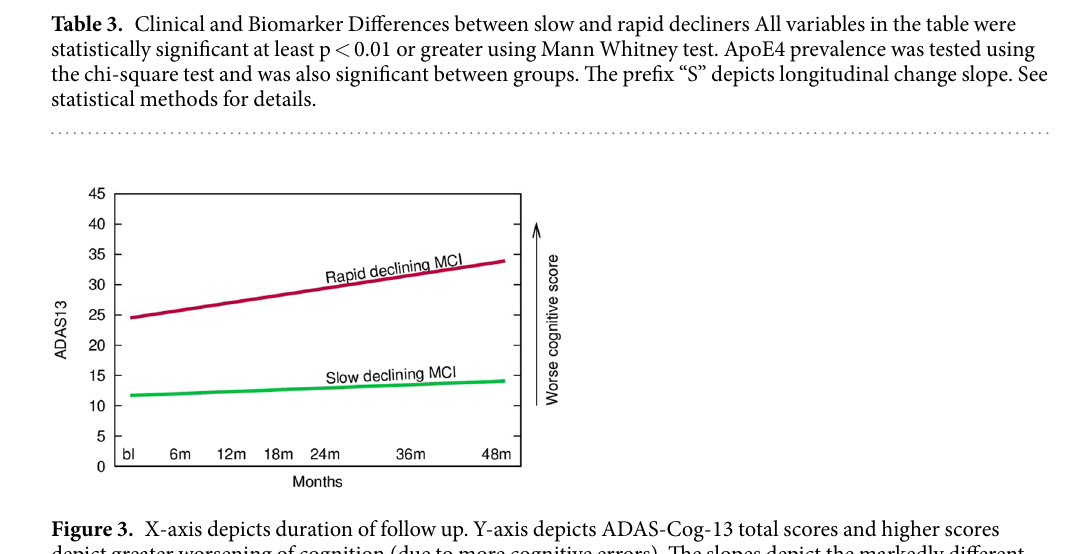
conditions. Using combined cut-off scores from ADAS11 and ADAS13 yielded the highest accuracy (Table 4). An MMSE cut-off < 27 yielded the worst sensitivity and specificity of 56.8% and 74.3% in ADNI1 and 46.9% and 79% in ADNI2. The RAVLT-immediate < 30 yielded intermediate accuracy.